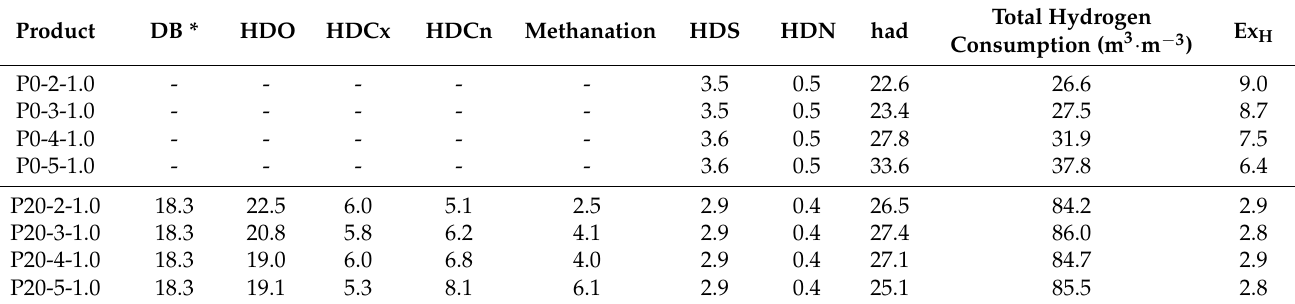
Table 5. The hydrogen consumption (m 3 · m − 3 ) for the individual reactions, total hydrogen consumption and